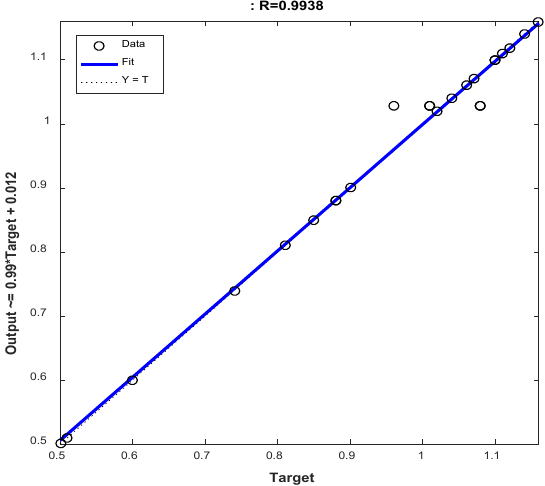
Figure 12. ANN-PSO regression line for training.